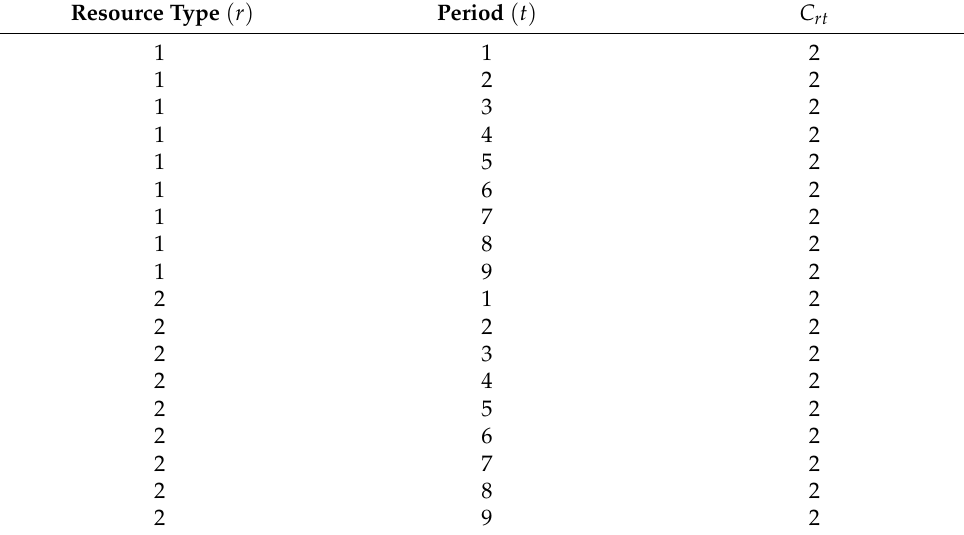
Table 4. The nominal capacity of each type of resources in each